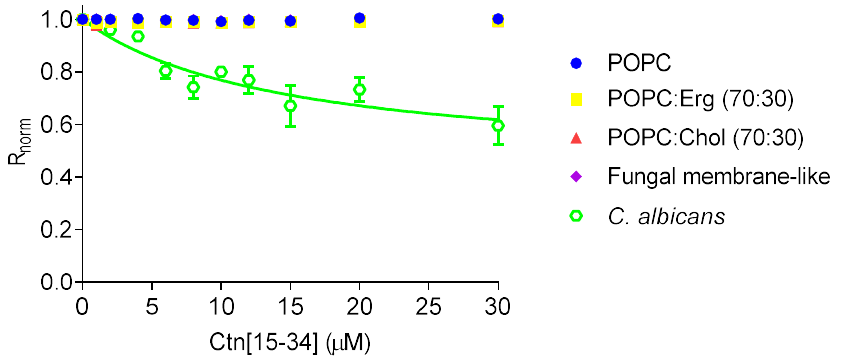
Figure 3. Interaction of Ctn[15–34] with lipid vesicles and C. albicans protoplasts, assessed with the membrane dipole potential-sensitive probe di-8-ANEPPS. The excitation ratio, R (I 455 / I 525 ), was normalized by dividing by the R value obtained in the absence of Ctn[15–34]. Equation (1) was used to fit the experimental data. Data are presented as mean ± SD of three independent measurements.